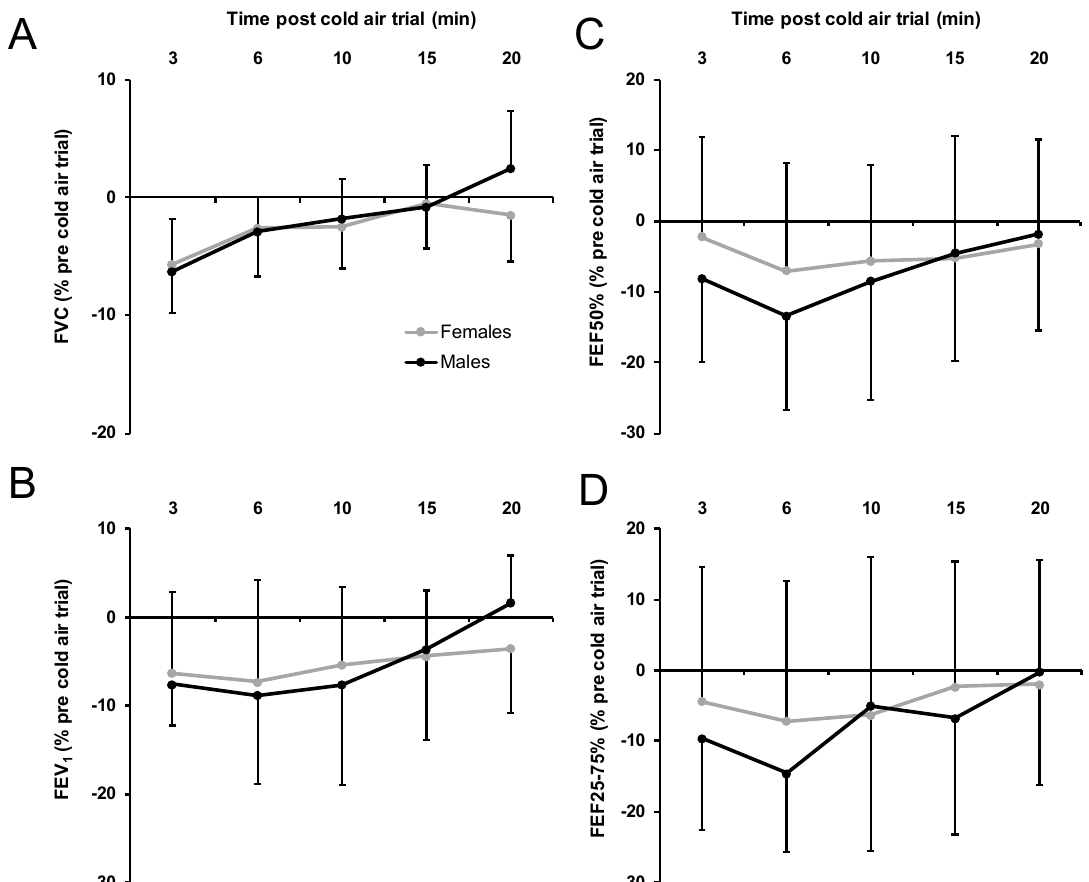
Figure 4. Acute respiratory recovery variables at -20 °C FVC ( A ), FEV 1 ( B ), FEF50% ( C ), FEV25–75% ( D ) expressed as % from pretrial values separately for females and males. Negative values show a decrease from pretrial values. FVC, forced vital capacity; FEV 1 , forced expiratory volume in 1 second; FEF50%, forced expiratory flow at 50%, FEF25–75%, forced expiratory flow at 25–75%; error bars indicate standard deviations.